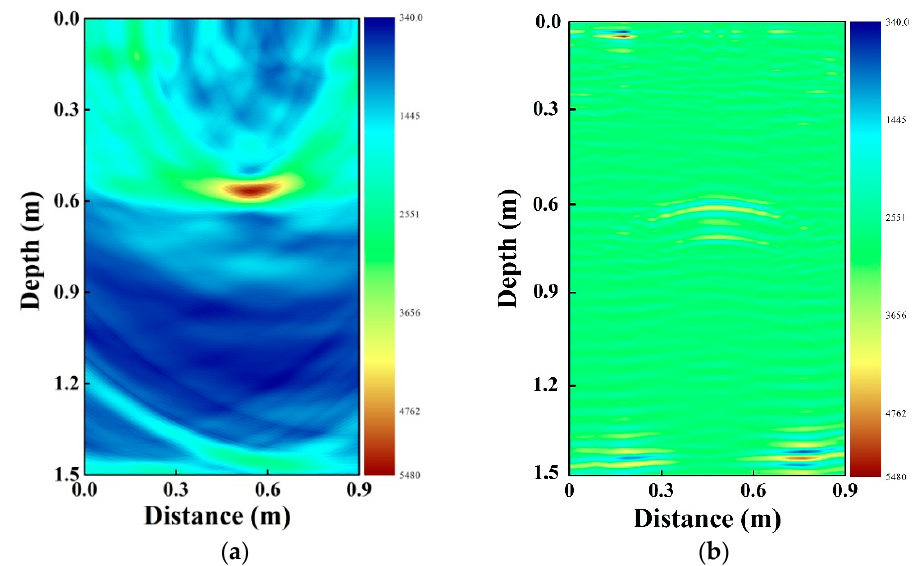
Figure 9. ( a ) Plastic location based on chaotic signals radar and ( b ) plastic location based on stepped frequency signal radar.